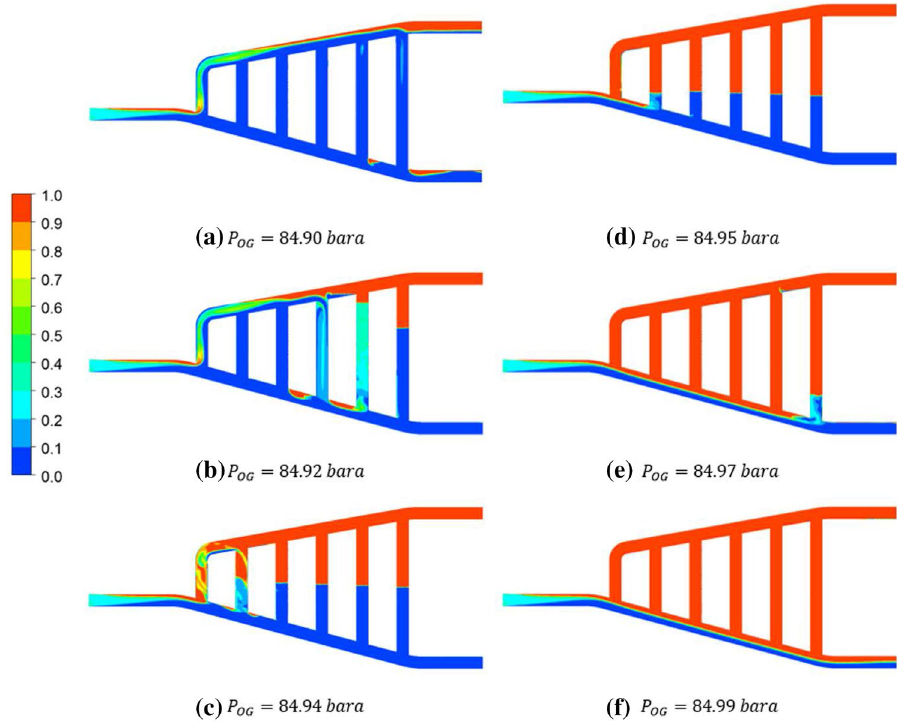
Fig. 6 GVF plot of differ- ent outlet gas pressures. Note Screenshots are made at the end of the total simulation time